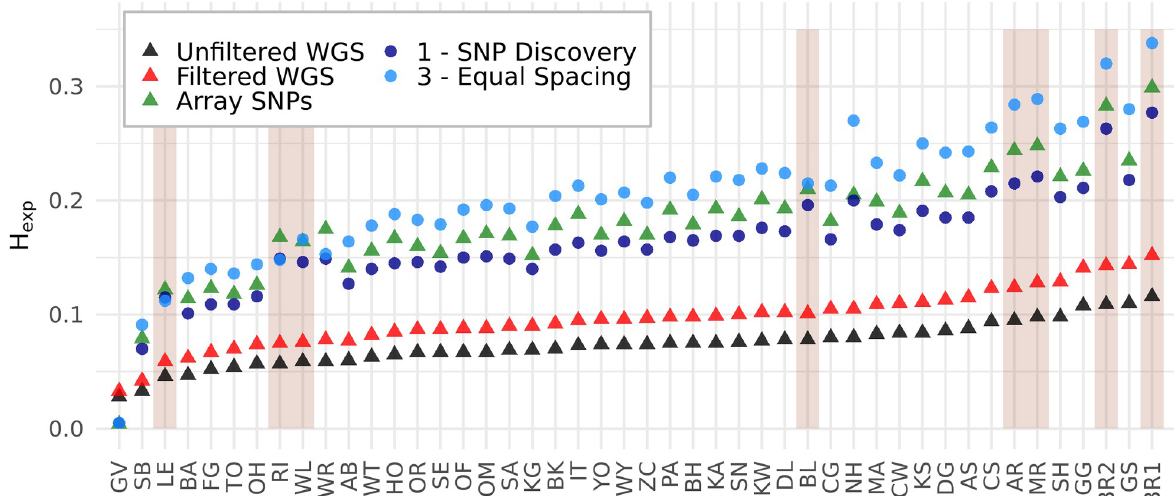
Fig 5. Expected Heterozygosity (H exp ) by population and SNP set. Populations are ordered by the H exp of the unfiltered WGS SNP set. Only the reference sets and relevant steps of the array design are shown. Discovery populations are shaded with a darker background.